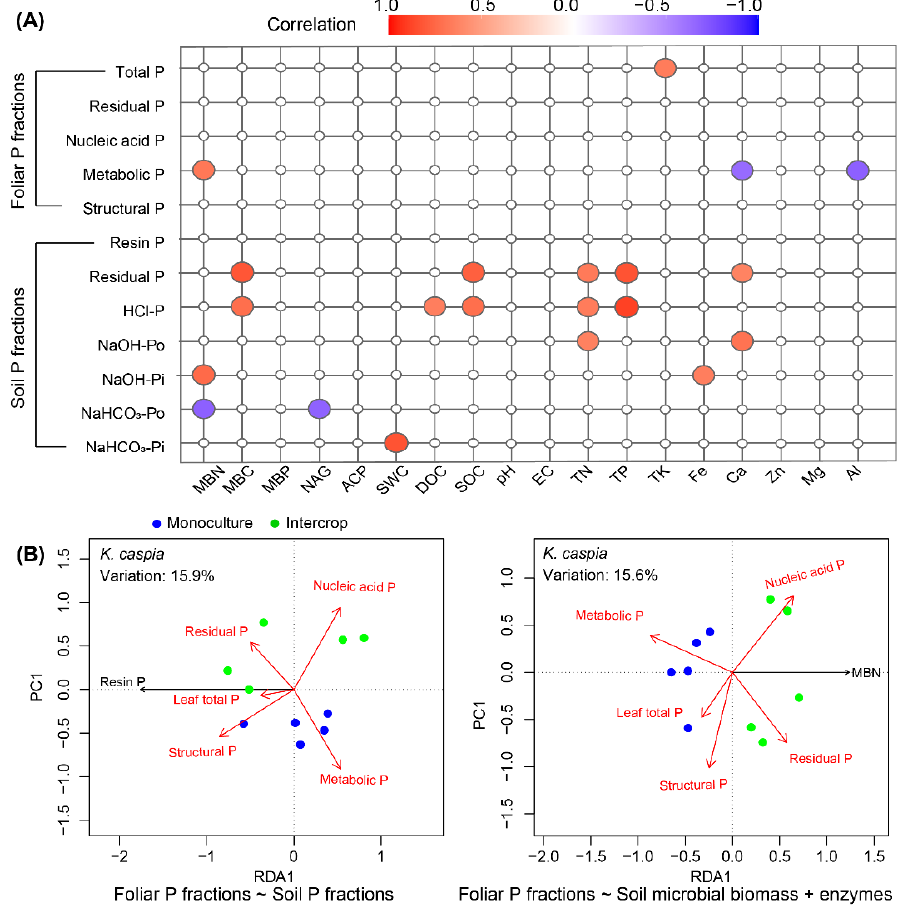
Figure 9. Relationships between foliar P and soil P fractions and environmental factors in the K. caspia monoculture and its intercropped plots. Subplot ( A ) shows the Pearson’s correlation between foliar P and soil P fractions and soil properties, and only significant correlations, either positive (red circles) or negative (blue circles) ( p -value < 0.05) are displayed. Subplot ( B ) shows redundancy analysis (RDA) of the relationship between foliar P fractions and soil P fraction ( left ) and soil microbial biomass and enzymes ( right ); RDA plots show only the factor closely related to foliar P fractions (screened using the forward selection model with 999 permutations performed in the vegan package in R). The foliar P fraction variance is explained by the factor(s) shown in Figure S3C,D.